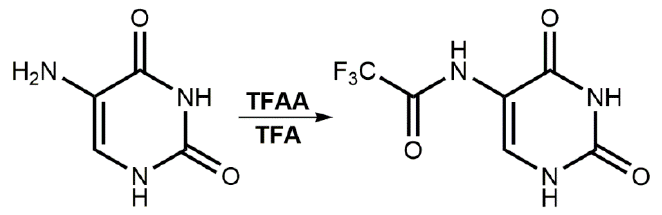
Figure 2. Synthesis of 5-( N -trifluoromethylcarboxy) aminouracil.